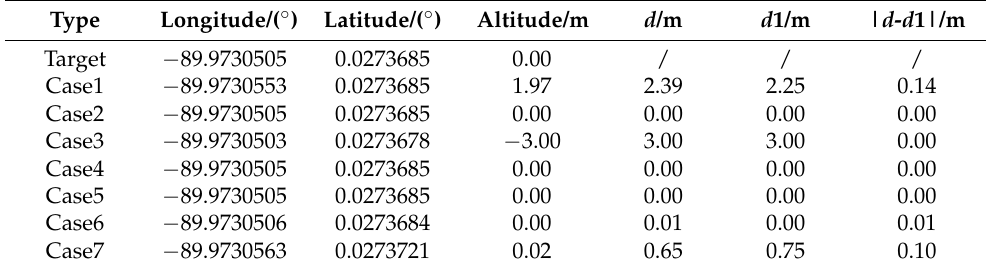
Table 4. Positioning Results and Location Errors of the